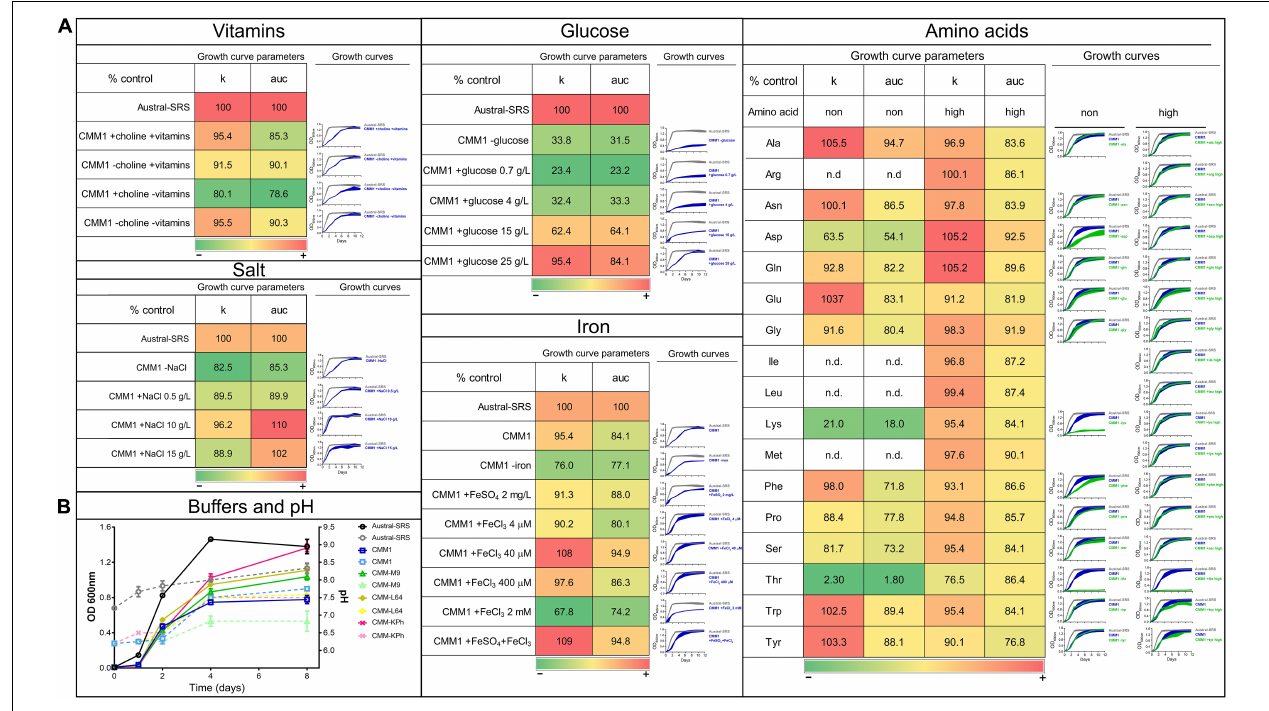
FIGURE 1 | Evaluation of nutrient composition and requirements for optimal growth of P. salmonis LF-89. Growth curves and growth curve parameters of P. salmonis LF-89 in the nutrient-rich medium Austral-SRS and the defined medium CMM1 with nutrient modifications. (A) The carrying capacity parameter (k) and the area under the curve of the fitted logistic equation for the OD 600 measurements over time (auc), with its corresponding growth curve, for the bacterial growth in Austral-SRS medium as control, CMM1 defined medium or CMM1 with modifications in the vitamins, salt, glucose, iron, and amino acid constituents. In the growth curve graphs, the control media (Austral-SRS) is shown in gray, and CMM1 media and its modifications are in blue. Amino acid changes (in green) were set in two concentrations: 0 g/L (shown in the column “non”) and at a higher concentration that the one used in CMM1 composition (column “high”). Essential amino acids required for bacterial growth were not tested (indicated with n.d.). Growth parameters are presented as percent of the control (Austral-SRS), higher values are shown in red, intermediate values are in yellow, and lower values are in green. (B) Growth curves of the bacterial growth (solid lines) and the culture media pH (dotted lines) using different buffers in the media. Specific composition of media is described in Supplementary Table 1